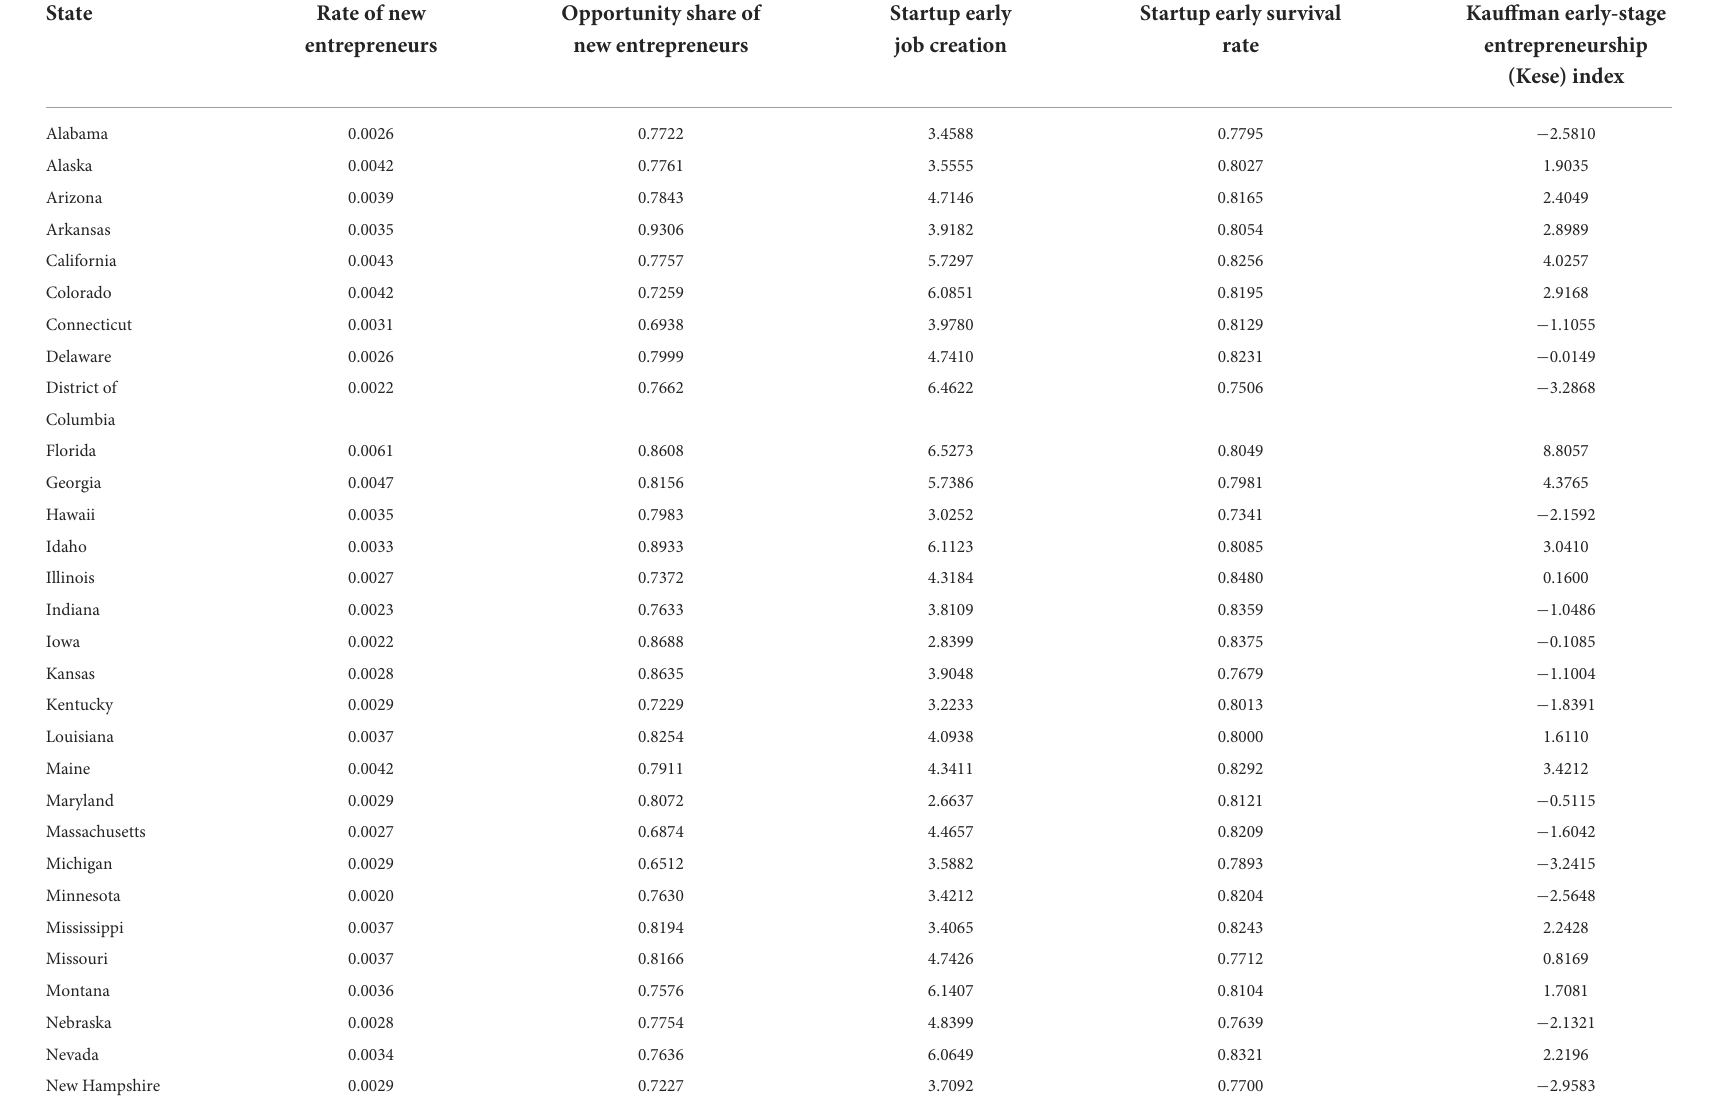
TABLE 4 State level early-stage entrepreneurship indicators in the United States in